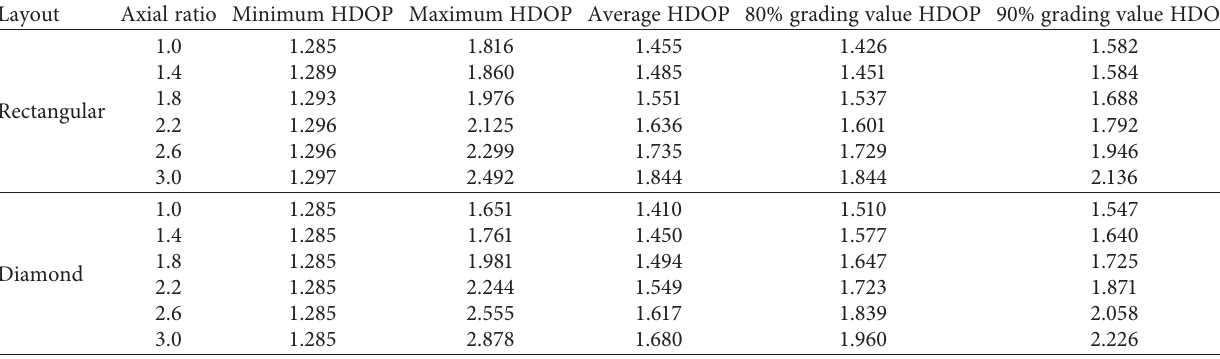
Table 1: Distribution characteristics of the HDOP in rectangular and diamond layouts with different axial ratios. Layout